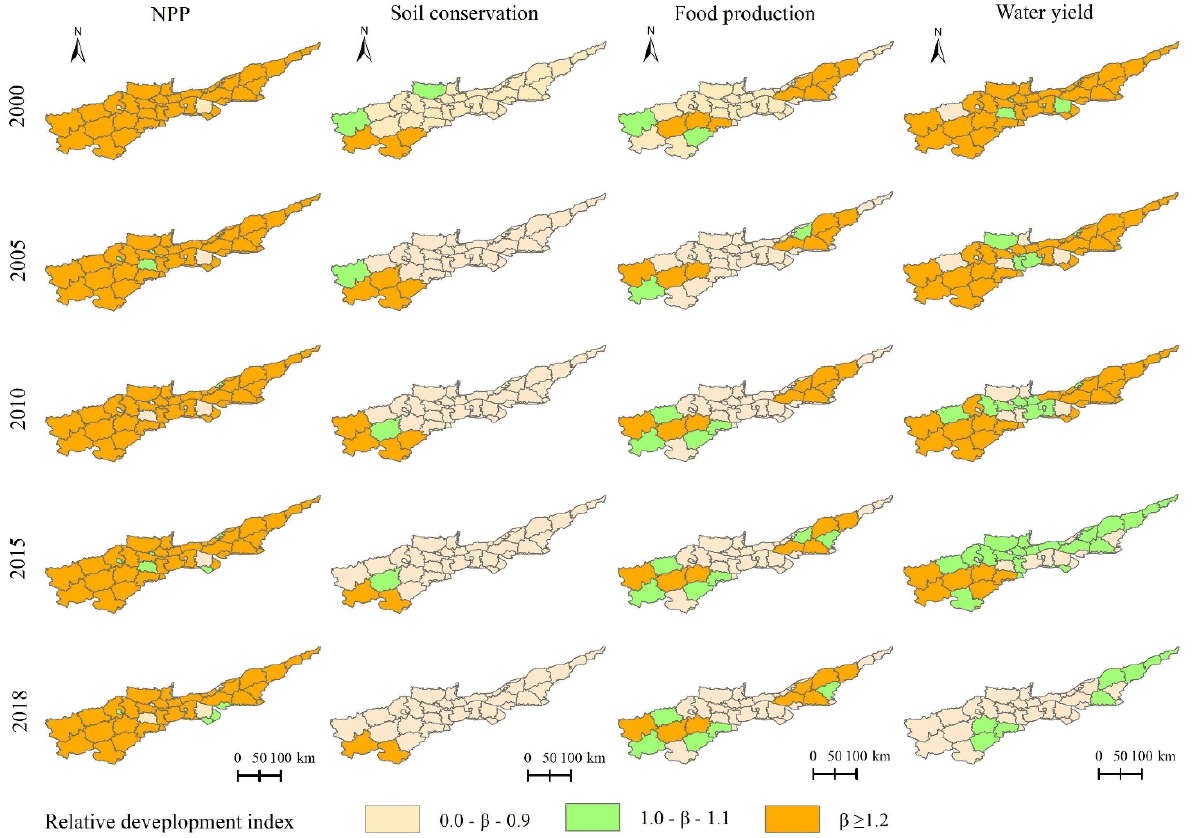
Figure 11. Spatiotemporal change in the relative development of ESs and comprehensive urbanization in the AYRHP on the county scale.